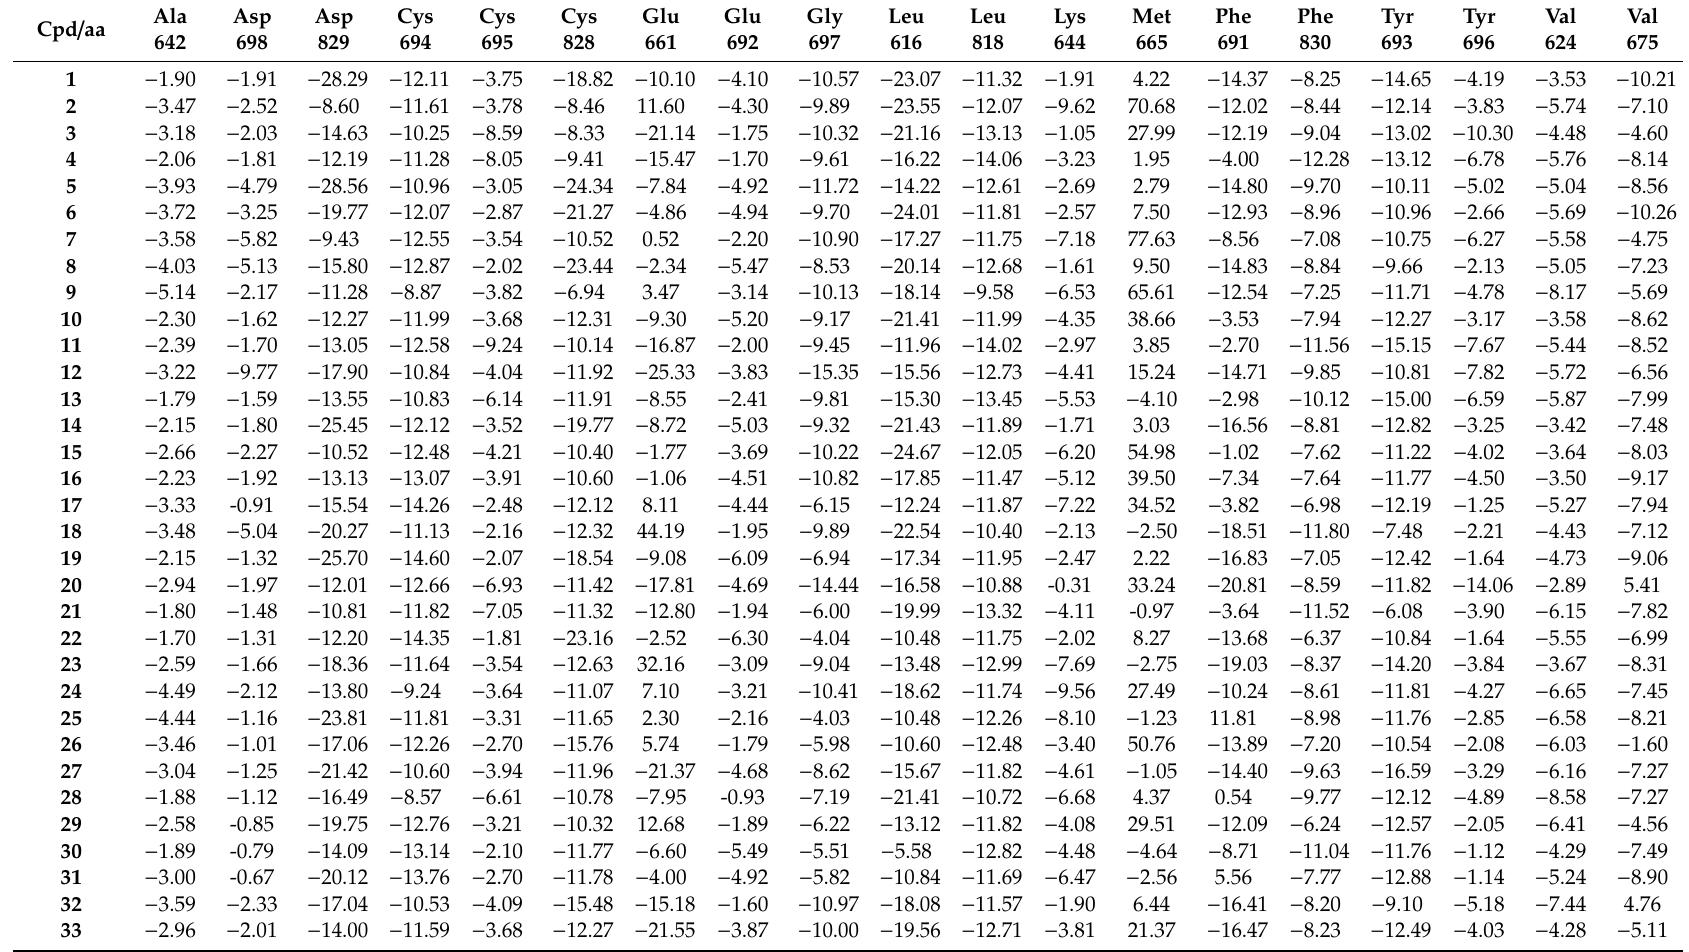
Table 2. Interaction energy values (kcal mol − 1 ) between amino acid residues and ligand for training and test